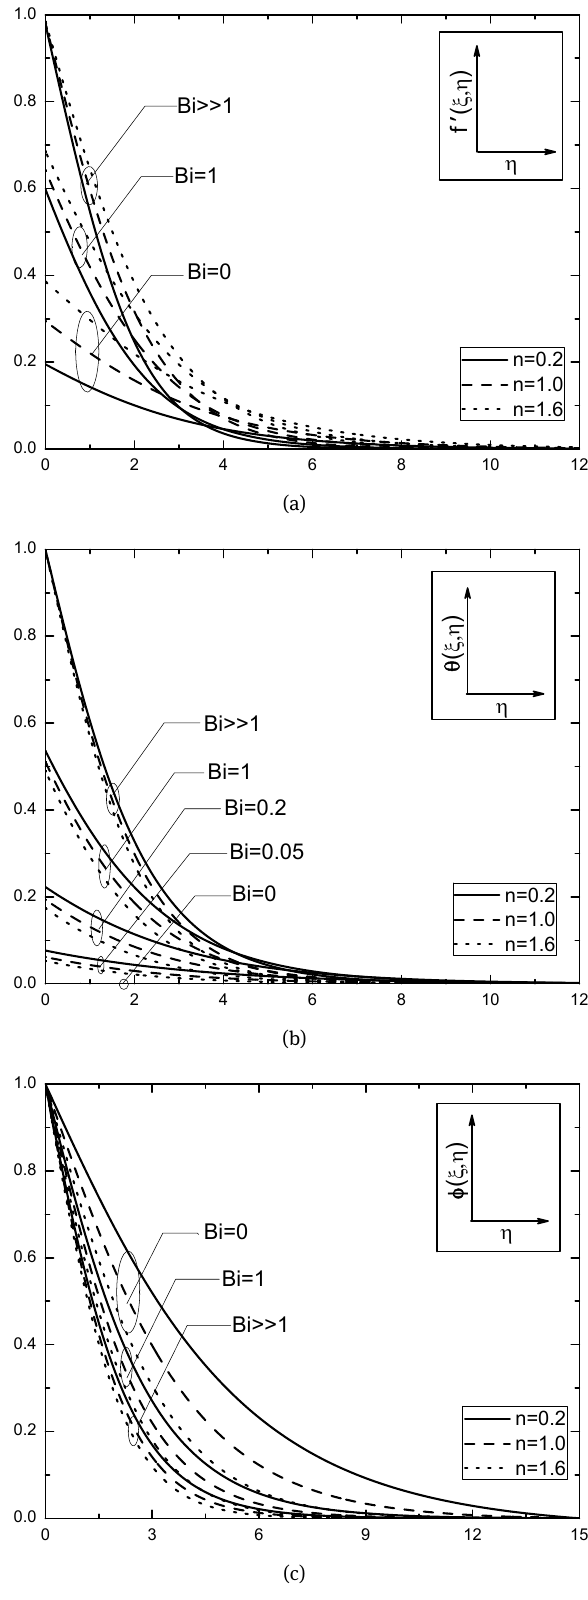
Fig. 5: Effect of Bi for different values of n on the (a) f ′ ( ξ , η ) , (b) θ ( ξ , η ) , and (c) ϕ ( ξ , η ) with the fixed values of α 1 = 1 , α 2 = 1 , Ω = 30 0 , ξ = 0.5